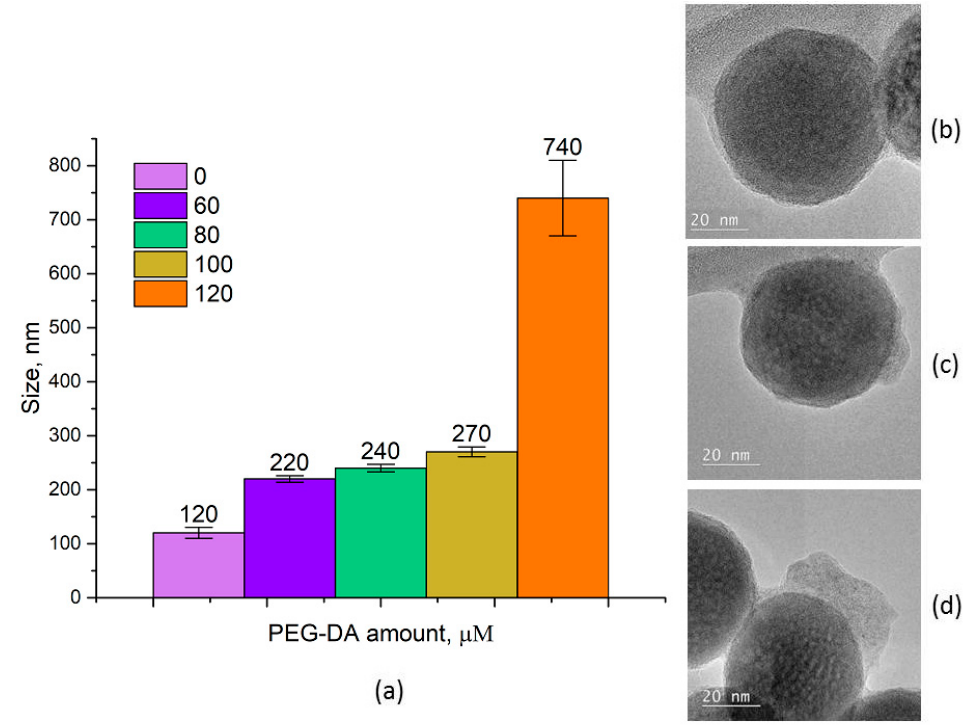
Figure 6. ( a ) Hydrodynamic sizes of UCNP–GMA–PEG via PEG-DA concentration, measured by dynamic light scattering; TEM images of nanoparticles: ( b ) UCNP–GMA; ( c ) UCNP–GMA–PEG, 60 µ M PEG-DA; ( d ) UCNP–GMA–PEG, 100 µ M PEG-DA. GMA = glycidyl methacrylate; PEG = polyethylene glycol; PEG-DA = polyethylene glycol diacrylate. Molecules 2019 , 24 , x FOR PEER REVIEW